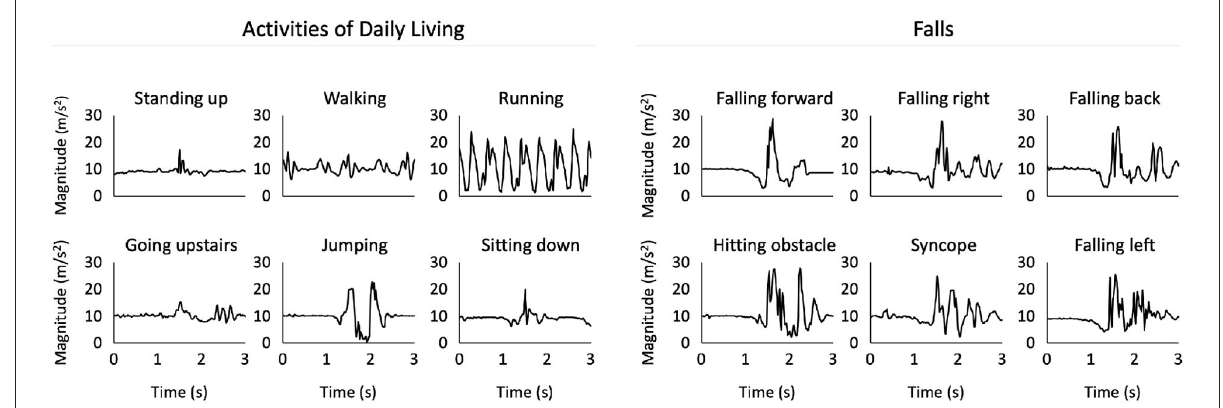
FIGURE5 Our plot of acceleration magnitudes for different types of activities of daily living and falls, based on data retrieved from the UniMiB-SHAR (25) dataset. Amplitude and signal frequency differences are apparent from visual